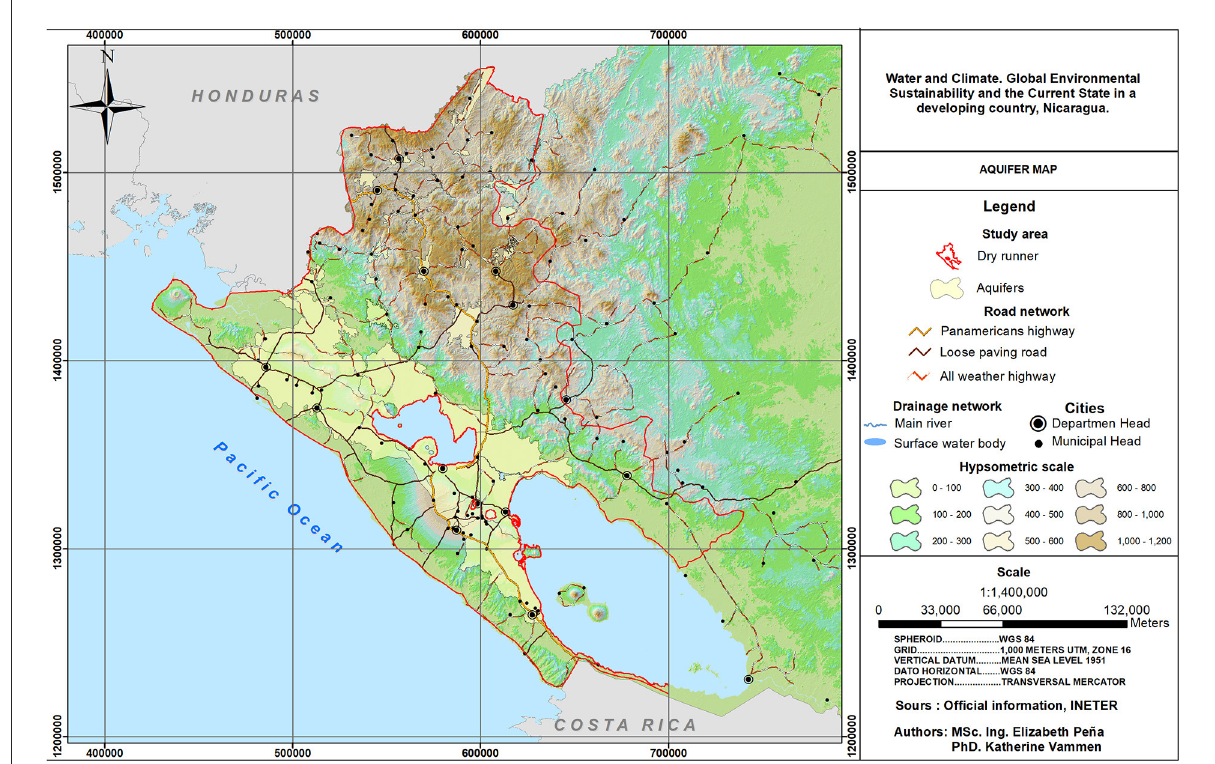
FIGURE2 Map of location of aquifers. Prepared by authors with official information of INETER.